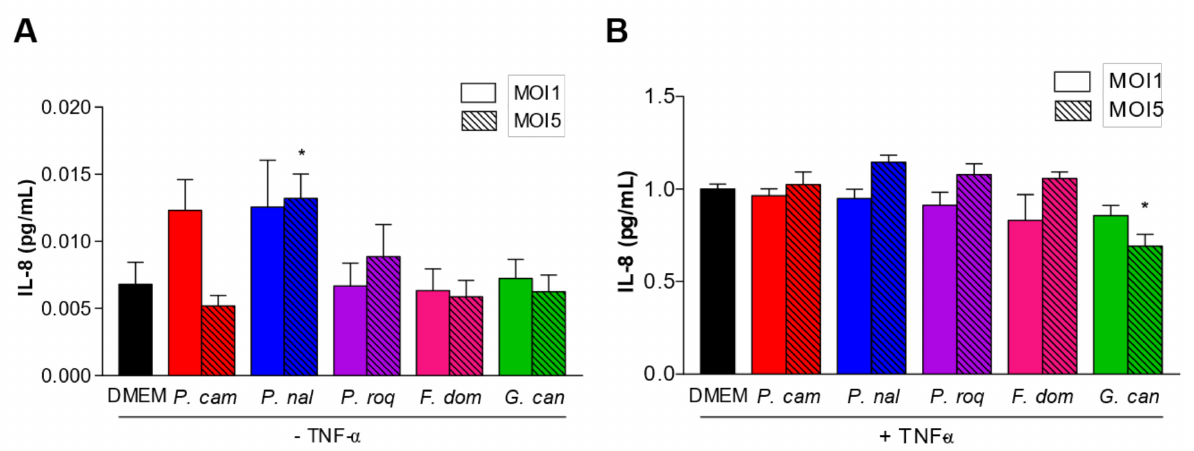
Figure 2. IL-8 production between filamentous strains. IL-8 production by HT29 after co-culture with filamentous strains Penicillium camemberti ( P. cam ), P. nalgiovense ( P. nal ), P. roqueforti ( P. roq ), Fusarium domesticum ( F. dom ), or Geotrichum candidum ( G. can ) at MOI1 and MOI5, ( A ) without or ( B ) with TNF- α priming. For statistical comparisons, (*) indicates versus DMEM. * p <